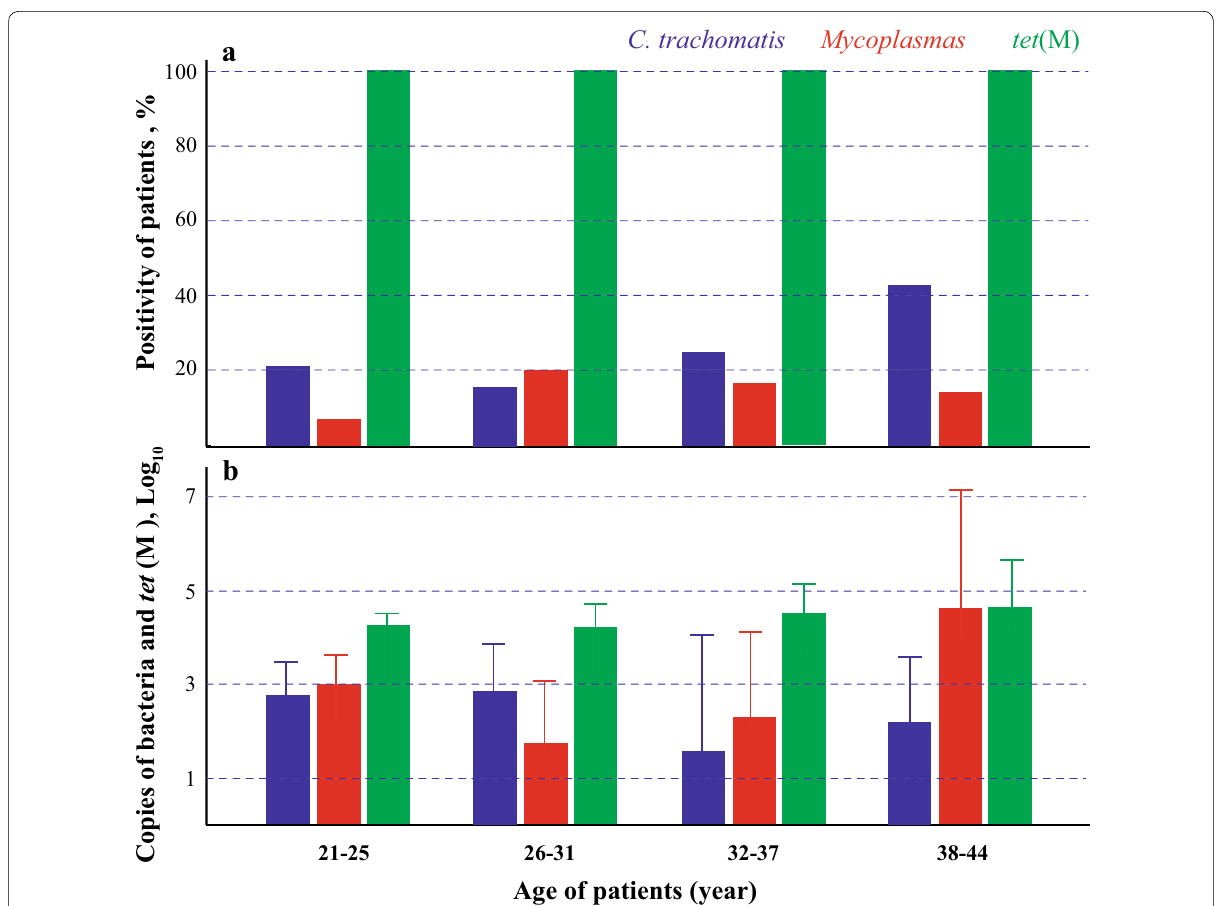
Fig. 3 Prevalence and copy numbers of C. trachomatis , Mycoplasma and tet (M) gene in vaginal samples in four age groups. a The C. trachomatis positivity in 21–25 age group, 26–31 age group, 32–37 age group and 38–44 age group detected in this study were 21.4, 15.7, 25.0 and 42.9% respectively. The Mycoplasma positivity in above four age groups detected in this study were 7.1, 20.5, 16.7 and 14.3% respectively. The tet (M) gene positivity in above four age groups were all 100%. b The average gene copy numbers for C. trachomatis 23S rRNA, Mycoplasma spp. 16S rRNA and tet (M) gene were 10 2.53 ± 1.05 SEM , 10 2.81 ± 1.24 SEM , 10 4.28 ± 1.34 SEM (being equivalent to 27,855 SEM), respectively. The gene copy number for four age groups did not differ significantly for C. trachomatis , Mycoplasma spp. and tet (M). However, the tet (M) copy number is significantly higher than C. trachomatis (averagely 7.6 times), and Mycoplasma spp. (averagely 14.7